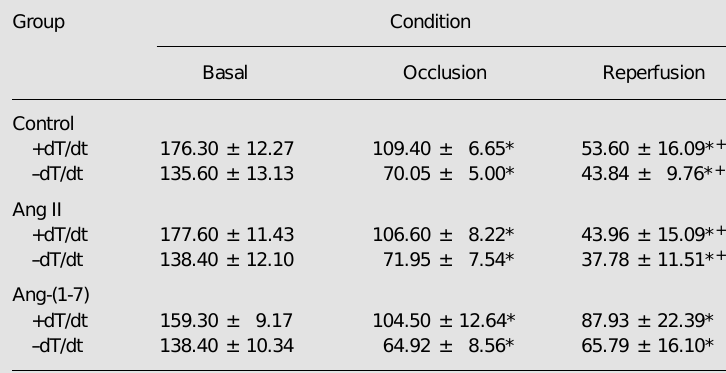
Table 1. Time course of the first derivative of systolic (+dT/dt) and diastolic (-dT/dt) tension in isolated rat hearts perfused with Krebs-Ringer solution (KRS) containing Ang-(1-7) or Ang II, before, during and after occlusion of the left anterior descending coronary artery.